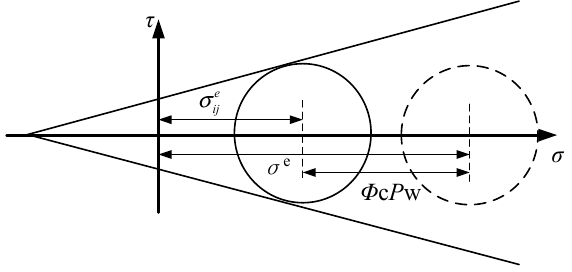
Figure 3. Schematic diagram of effective stress and coal body strength of coal containing gas.